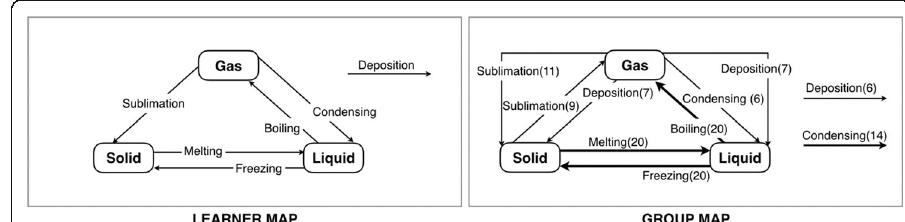
Fig. 2 An example of the learner map and the group